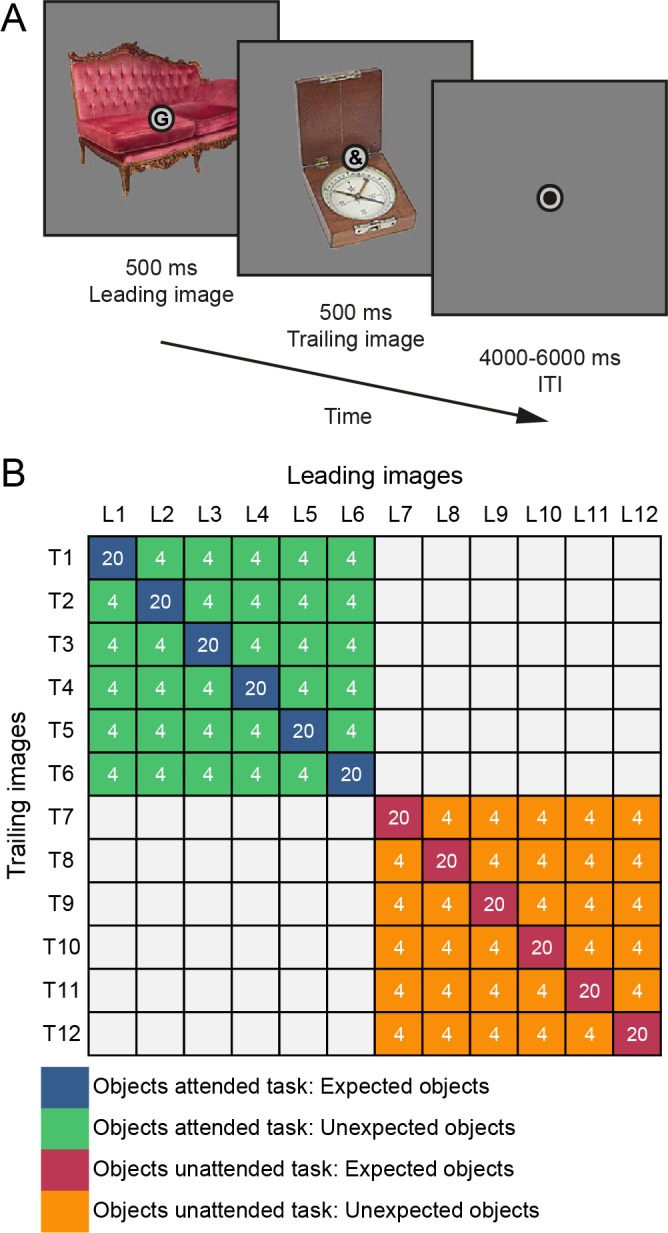
Experimental paradigm.(A) A single trial is displayed, starting with a 500 ms presentation of the leading object and the leading character superimposed at fixation. Next, without ISI, the trailing object and trailing character are shown for 500 ms. Each trial ends with a 4000–6000 ms ITI (MRI session; 1000–2000 ms ITI learning session), showing only a fixation dot. (B) Statistical regularities depicted as image transition matrix with object pairs and trial numbers during MRI scanning. L1 to L12 represent leading objects, while T1 to T12 represent the trailing objects. Leading and trailing objects were randomly selected per participant from a larger pool of images - that is, leading images of one participant may occur as trailing objects of another participant, in a different task, or not at all. Blue cells denote expected object pairs of the objects attended (object categorization) task, while green indicates unexpected object pairs of the objects attended task. Red denotes expected objects of the objects unattended (character categorization) task, and orange indicates unexpected objects of the objects unattended task. Each participant was also assigned 12 leading and 12 trailing characters (six letters, six symbols each). Unlike the object images, there was no association between leading and trailing characters – that is, the identity of the leading and trailing character was unpredictable. White numbers represent the total number of trials of that cell during MRI scanning. In total 120 trials of each of the four conditions were shown during MRI scanning per participant. In the behavioral learning session, participants performed an orthogonal oddball detection task, during which only expected pairs were shown (i.e., only the diagonal of the matrix), for a total of 80 trials per expected pair (960 trials total).